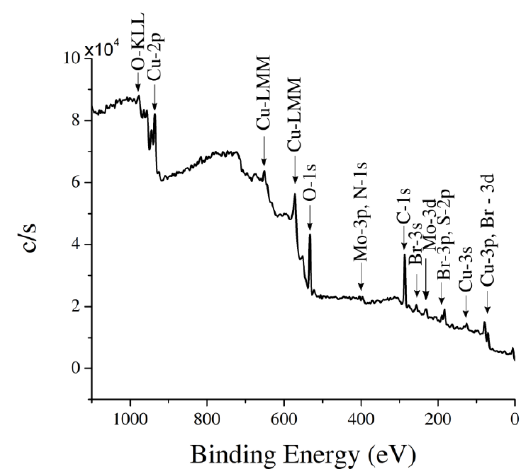
Figure 4. XPS survey spectra of a stainless steel AISI 316L coated with a Cu–MoS 2 composite coating.